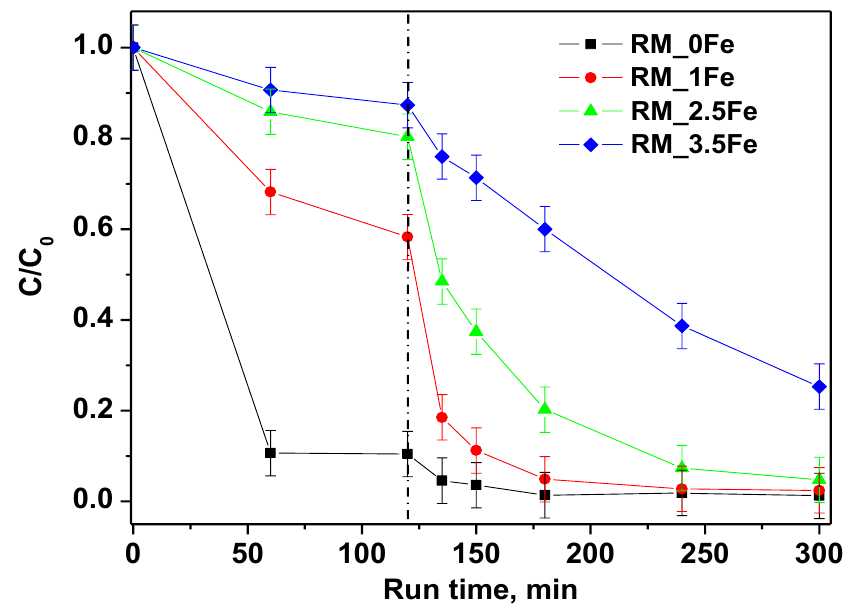
Figure 9. Photocatalytic discoloration of CV aqueous solution with all the studied photocatalysts under visible irradiation (white light).